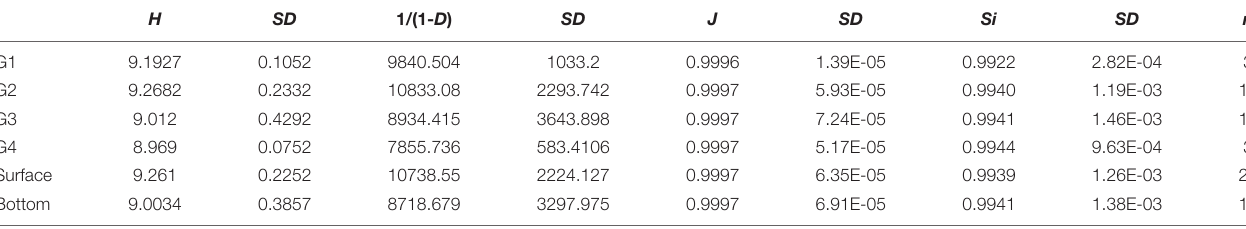
TABLE 1 | Diversity indices based on all probes detected in the